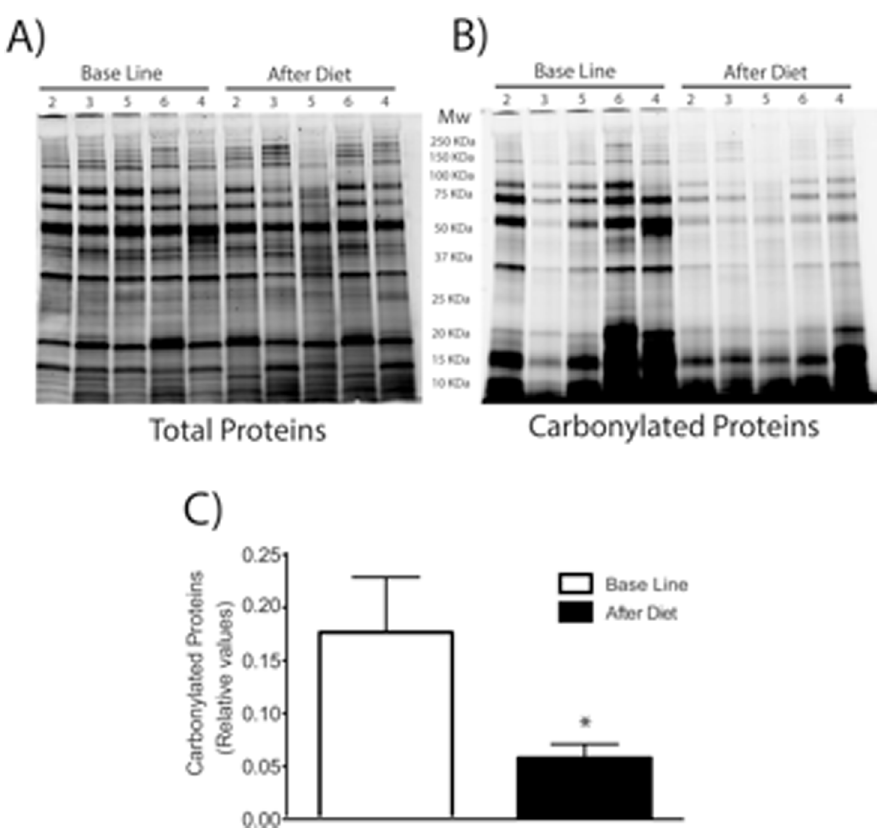
Figure 2. Oxidized damaged proteins before (Basal Line) and after treatment (After Diet). SDS-PAGE (4–20%) pattern of total proteins post-stained with ProteinGOLDTM (A), or carbonylated proteins pre-labeled with C5Hz (B). Semiquantification of carbonylated proteins were performed by densitometric analysis, expressed as relative values and shown as mean 6 S.D (n=5) and analyzed using Student’s t-test; * P=0.06 (C).